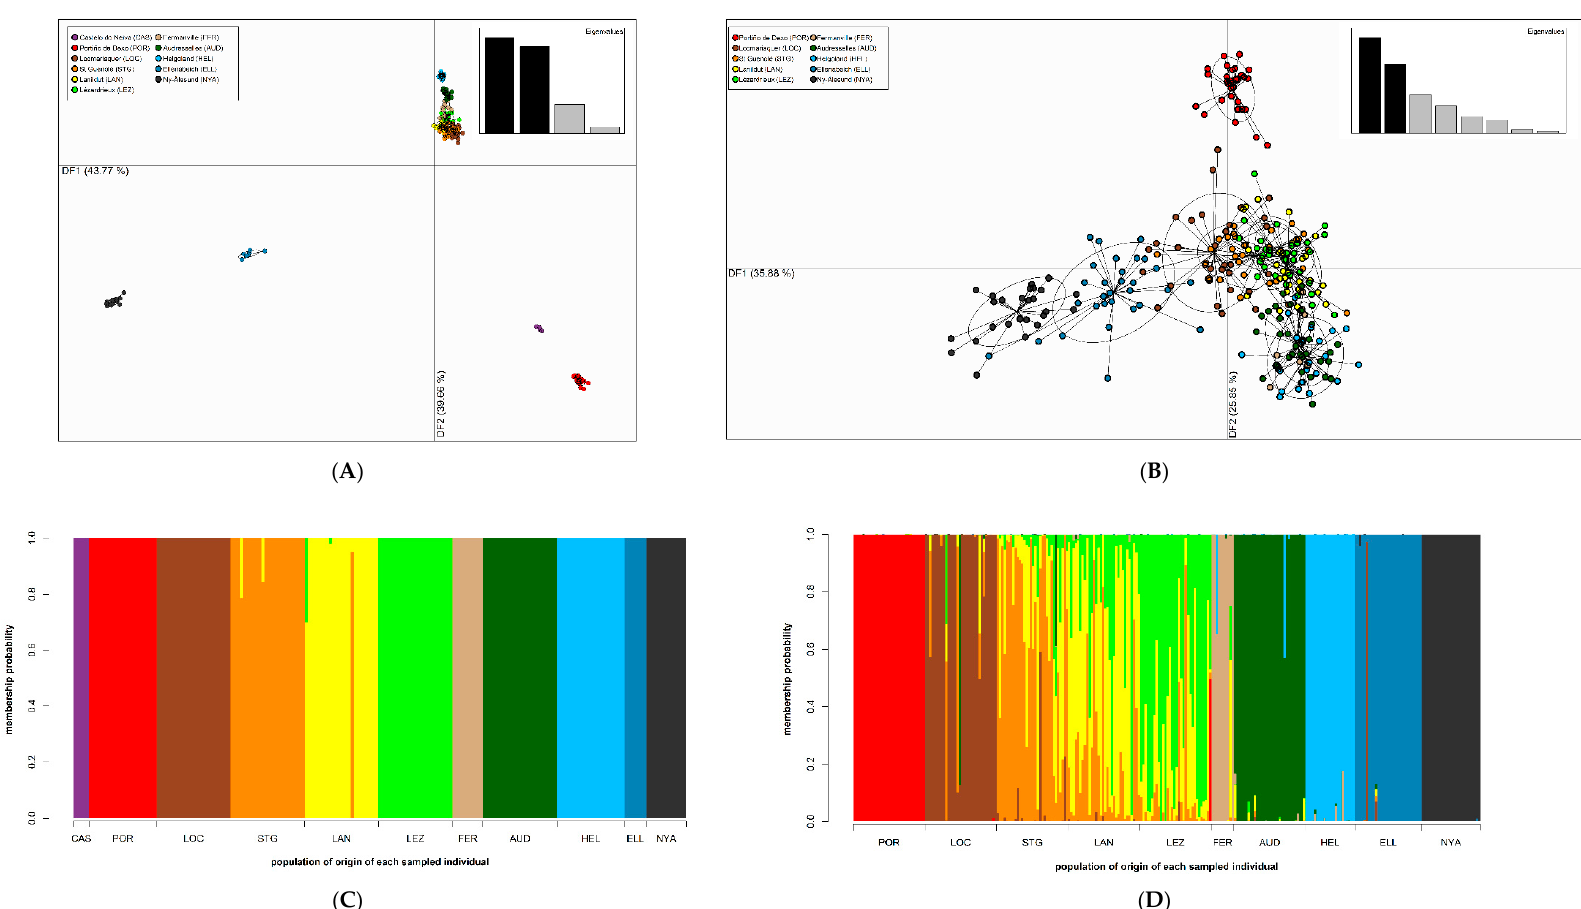
Figure 2. Discriminant analysis of principal components (DAPC) scatterplot and compoplot for ( A , C ) 199 S . latissima sporophytes sampled from 11 localities (see key) that were genotyped at 4069 SNP markers, and ( B , D ) 280 S . latissima sporophytes sampled from 10 localities (see key) genotyped at 18 SSR markers. ( A , C ) display the first two components (axes 1 and 2) of the DAPC. Sampling localities, which were specified a priori for the DAPC, are di ff erentiated by color and inertia ellipses. Each point corresponds to a single individual. ( B , D ) show DAPC posterior probability of membership of each of the analyzed S . latissima sporophytes (each sample is represented by a vertical bar) to each of the sampling sites (each represented by a unique